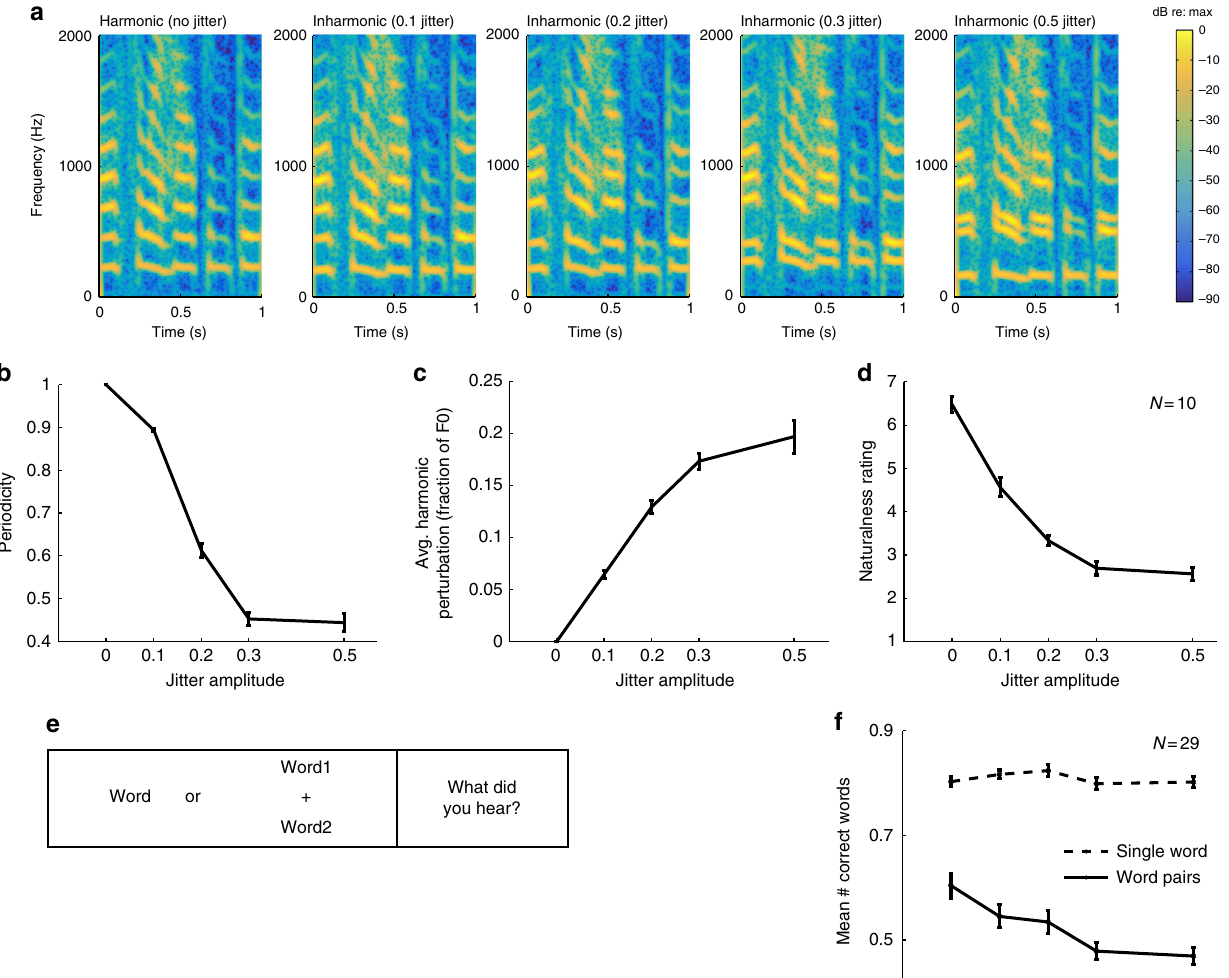
Fig. 3 Effect of inharmonicity on concurrent word segregation (Experiment 2). a Spectrogram of excerpts of harmonic and inharmonic speech with harmonics jittered by 0%, 10%, 20%, 30%, and 50% of the f0, respectively. b Waveform aperiodicity (the height of the peak of the autocorrelation function) for each jitter condition. c Average absolute harmonic perturbation for each jitter condition. Error bars here and in b plot standard deviation. d Ratings of naturalness of spoken sentences for different degrees of inharmonicity ( N = 10). e Schematic of trial structure for word segregation task. f Intelligibility of single words and concurrent word pairs as a function of the degree of inharmonicity ( N = 29). Error bars here and in d plot